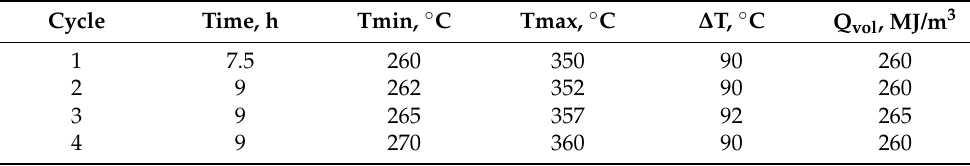
Table A1. Summary of data obtained from Heatcrete